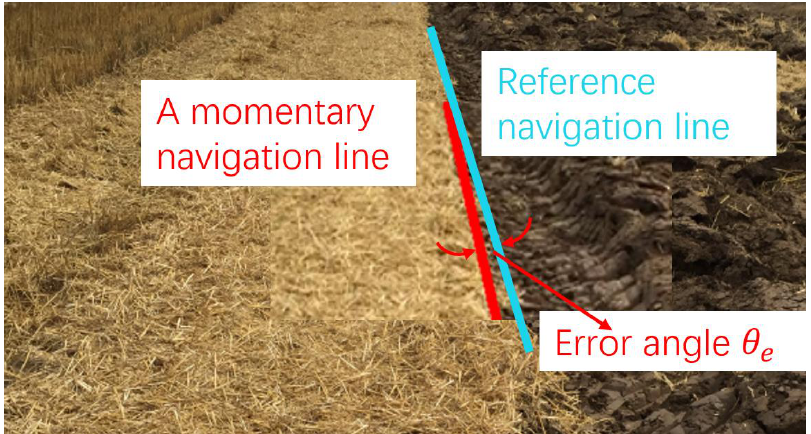
Figure 19. Navigation line extraction.